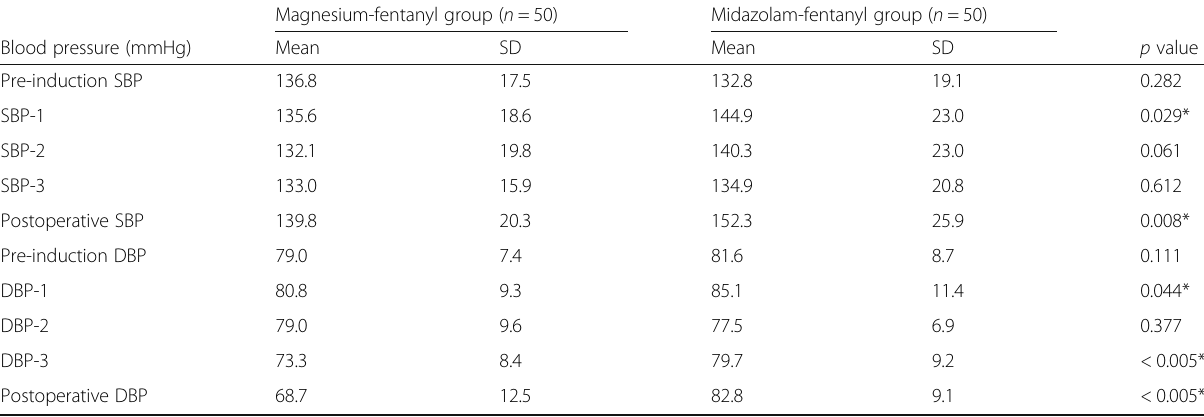
Table 3 Changes in systolic and diastolic blood pressures in both study groups Magnesium-fentanyl group ( n = 50) Blood pressure (mmHg)